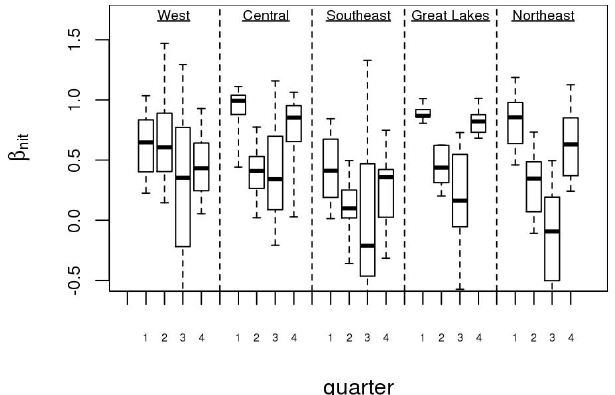
Fig. 10. Spatial and temporal trends in β nit